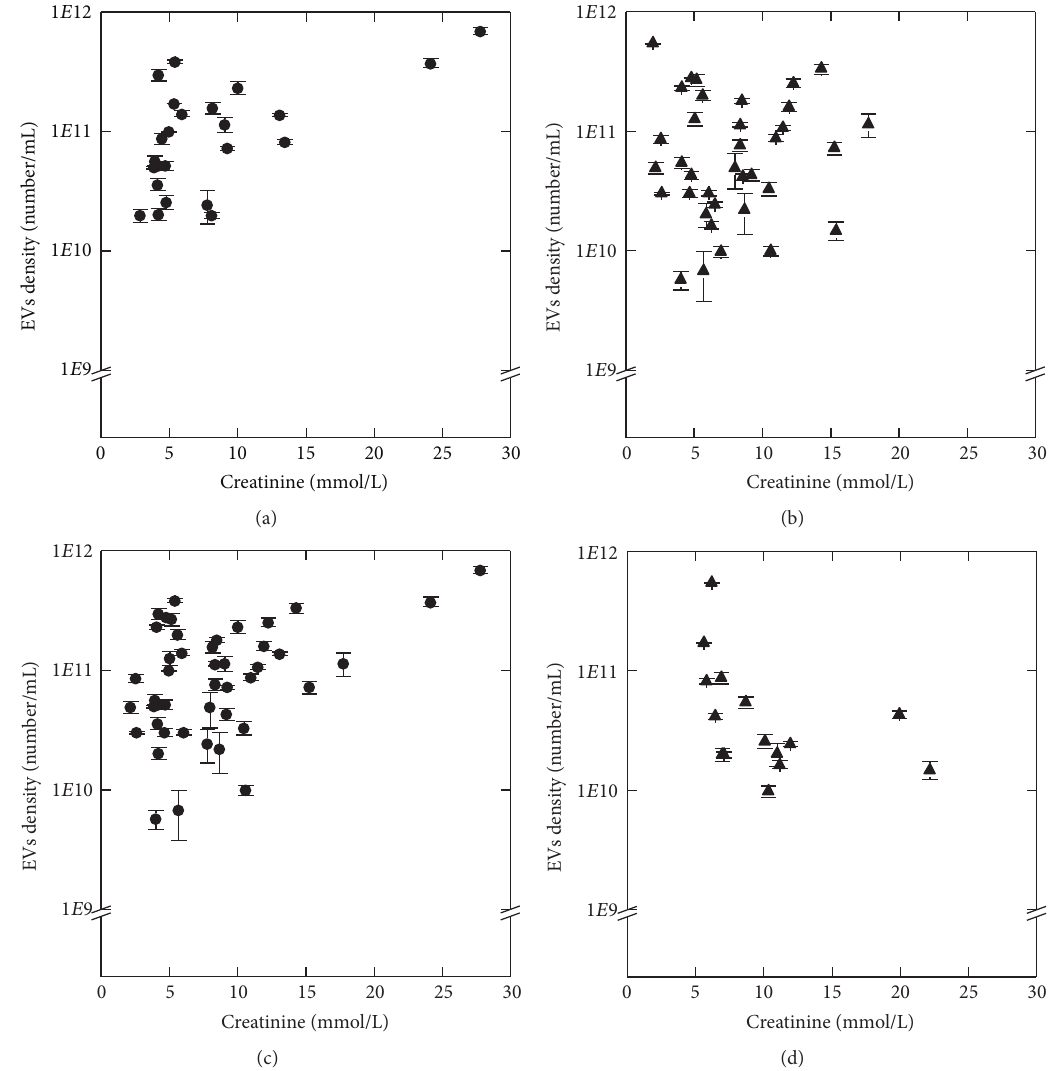
Figure 3: Relationship between EVs density and urine creatinine concentration in study groups: CD (a), UD (b), NRF (c), and RF (d). EVs density values are given as mean (SD). Spearman’s rank correlation coefficient, 𝑝 <